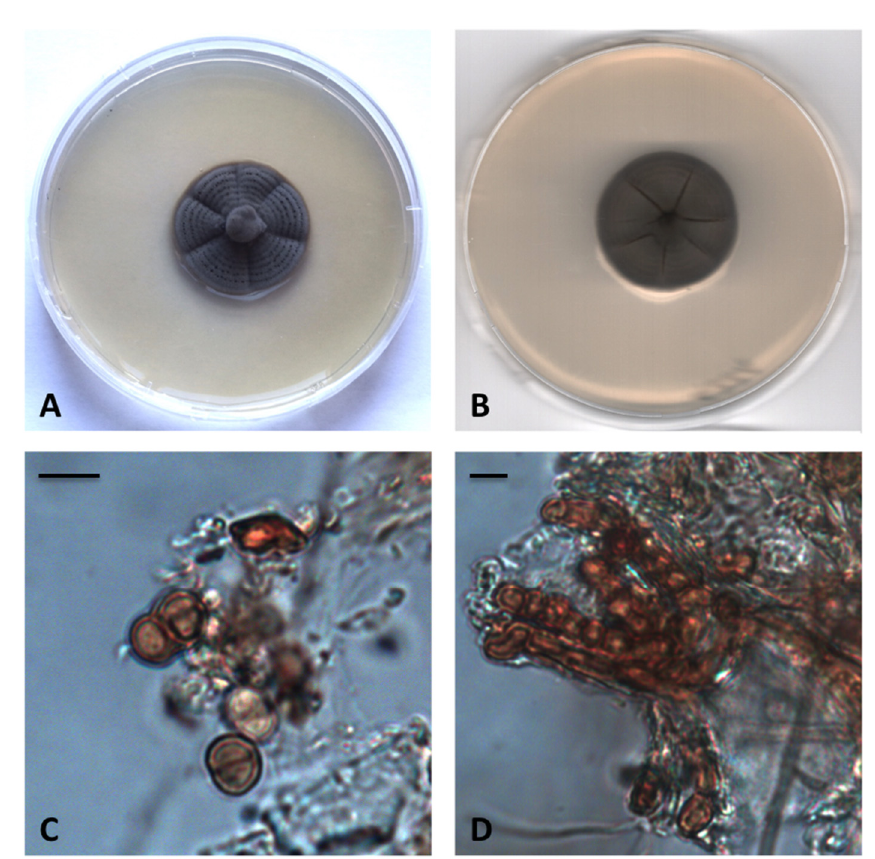
Figure 2. Parathyridariella dematiacea sp. nov. 28-days-old colony at 21 °C on MEASW ( A ) and reverse ( B ); solitary ( C ) and in chain ( D ) chlamydospores. Scale bars: 10 µm (C, D). Parathyridaria tyrrhenica sp. nov. A. Poli, V. Prigione, E. Bovio and G.C. Varese MYCOBANK: MB